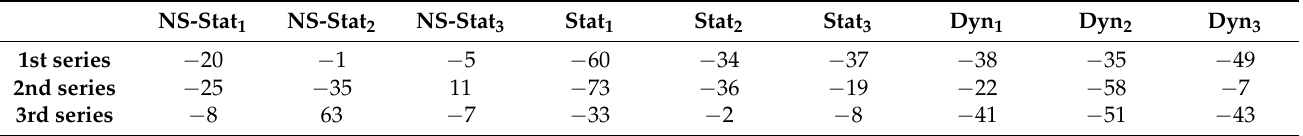
Table 1. Values of stiffness relative difference (in %) between d 0 and d 21 for all the samples of the three experimental campaigns. The red value has been considered as aberrant and removed from the statistical analysis. The subscripts 1, 2 and, 3 correspond to the three samples in each series. Samples from the same column (with the same name and subscript) are not associated.